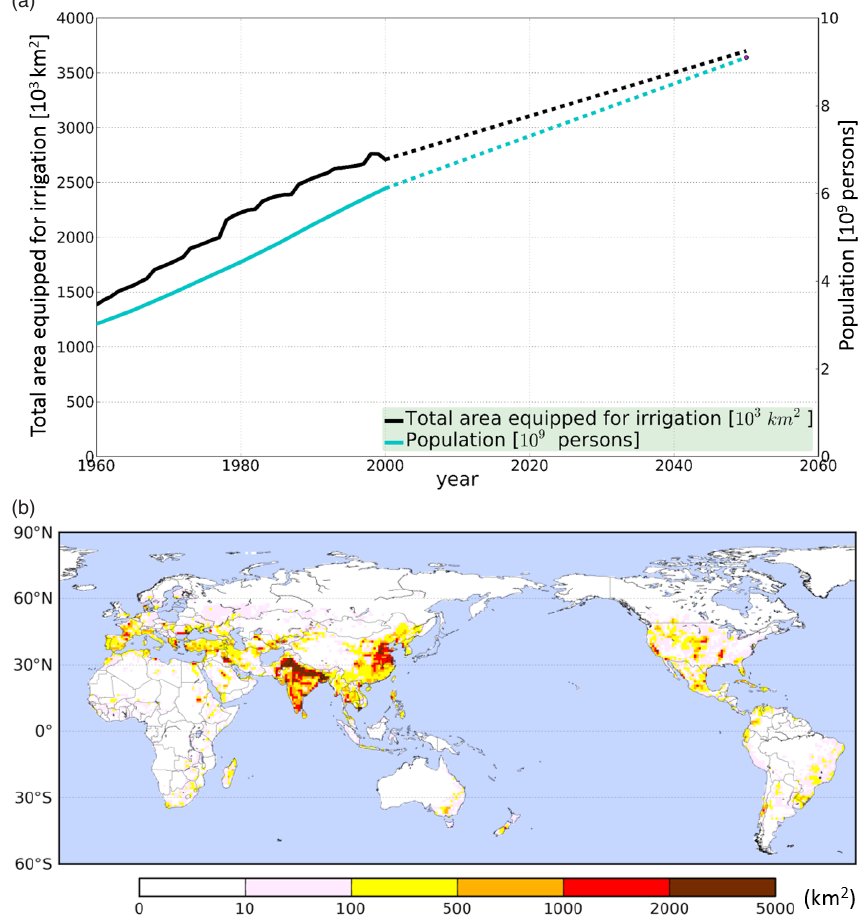
Figure 2. Global total area equipped for irrigation under historical irrigation map (HIM) data (10 3 km 2 ) during the period of 1960–2000 and irrigation scenarios due to population growth during the period of 2000–2050 and global total population (a) , and the difference in area equipped for irrigation (km 2 ) for the years 2000–1960 (b)